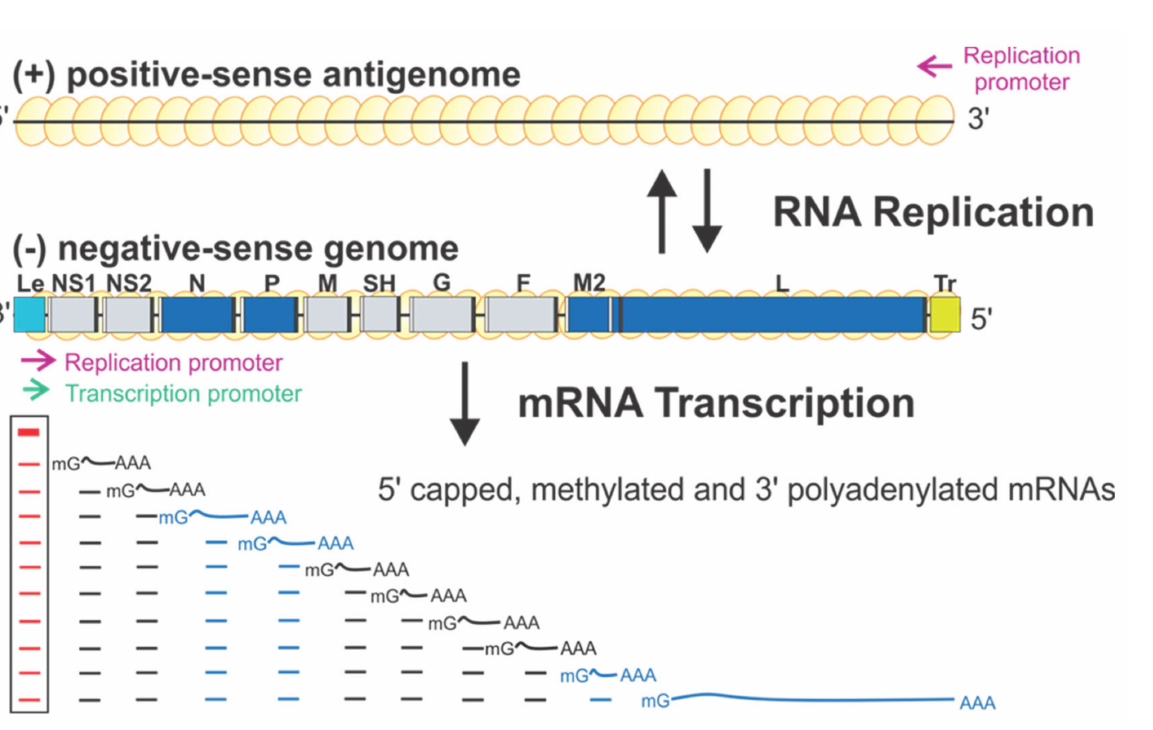
Figure 1. The schematic diagram of the genome organization and RNA synthesis of RSV. The leader (Le, cyan) and trailer (Tr, gold) are at 3 (cid:48) and 5 (cid:48) ends of the genome. The genes N, P, M2, L (blue), NS1, NS2, M, SH, G, and F (gray) are flanked with gene start (GS, white) and gene end (GE, black). Two replication promoters (magenta arrows) at 3 (cid:48) ends of the genome and antigenome and a single transcription promoter (green arrow) are shown. The mRNA transcription products with 5 (cid:48) methyl guanosine ( m G) caps and 3 (cid:48) poly-A (A n ) are below respective genes. Genome and antigenome are encapsidated with N proteins (yellow